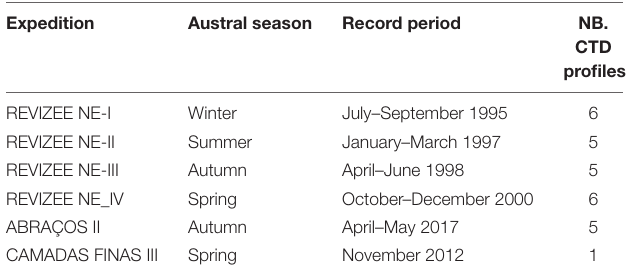
TABLE 1 | REVIZEE-NE expeditions organized according to the seasons of the year.